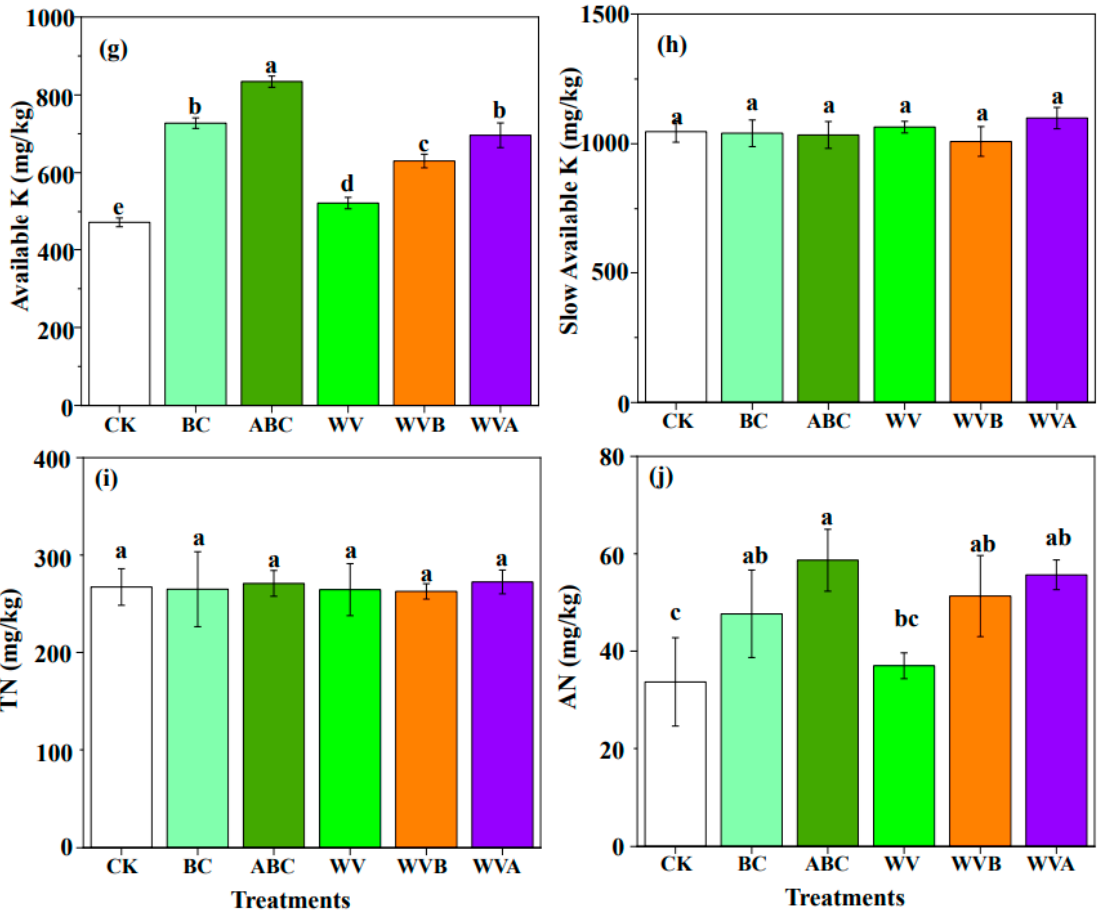
Figure 4. The transformations in pH ( a ), Electrical conductivity ( b ), Total organic carbon ( c ), Total potassium ( d ), Total phosphorus ( e ), Available phosphorus ( f ), Available potassium ( g ), Slow available potassium ( h ), Total nitrogen ( i ), and Available nitrogen ( j ) in different treatments (CK, BC, ABC, WV, WVB, and WVA) of coastal saline–alkali soil. The different letters among different treatments indicate significant differences, which were analyzed by Duncan’s test ( p = 0.05). Table 1. Selected characteristics of the sawdust biochar, acid-modified biochar, and wood vinegar.